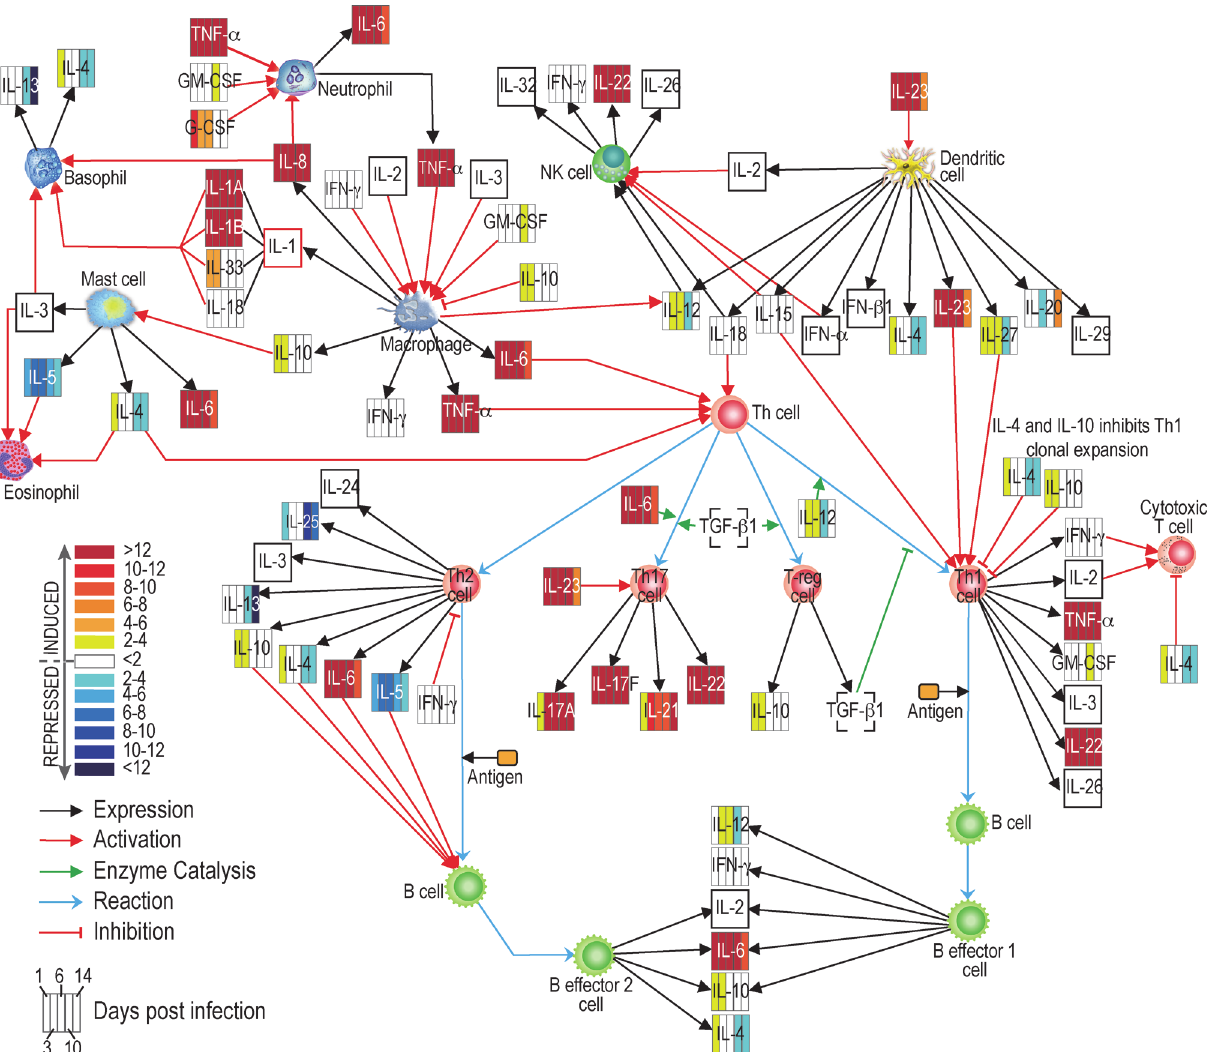
Fig 2. Changes in inflammatory molecule transcript levels during formation and resolution of S . aureus skin abscess. Gene expression data were obtained using RT 2 Profiler PCR Array Rabbit Inflammatory Cytokines and Receptors platform. The networks/functional analyses were generated through the use of QIAGEN ’ s Ingenuity Pathway Analysis (IPA, QIAGEN Redwood City, www.qiagen.com/ingenuity). The heat map represents changes in transcript levels of molecules on days 1, 3, 6, 10 and 14 of a 14-day course of infection (compared to uninfected skin), and was created using Adobe Illustrator CS5.1 software. Unfilled squares; transcript levels were not available. For simplicity, the encoded proteins (rather than transcripts) and potential pathways are shown. The interactions and functions shown here are hypothetical based upon the known (published) general function of each molecule. Further studies of S . aureus -host interaction are necessary to verify these pathways and protein function during